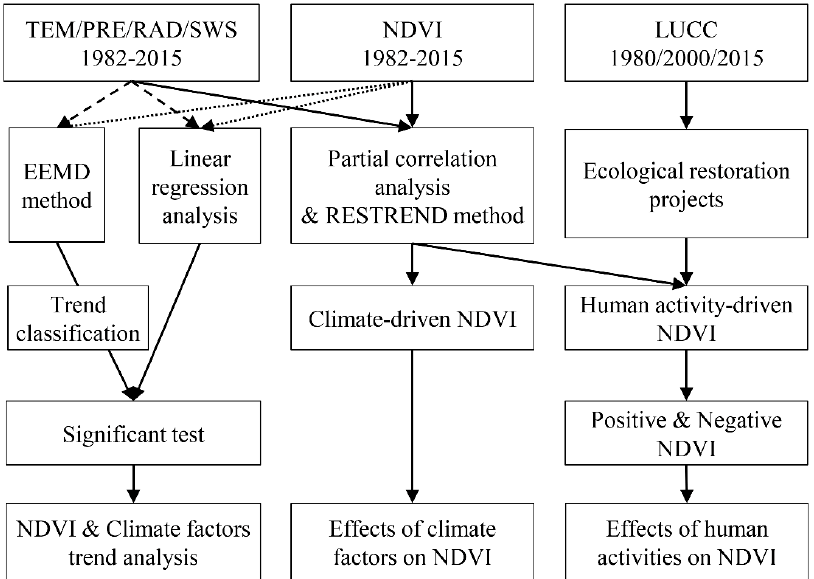
Figure 6. Workflow of the NDVI analysis methods and